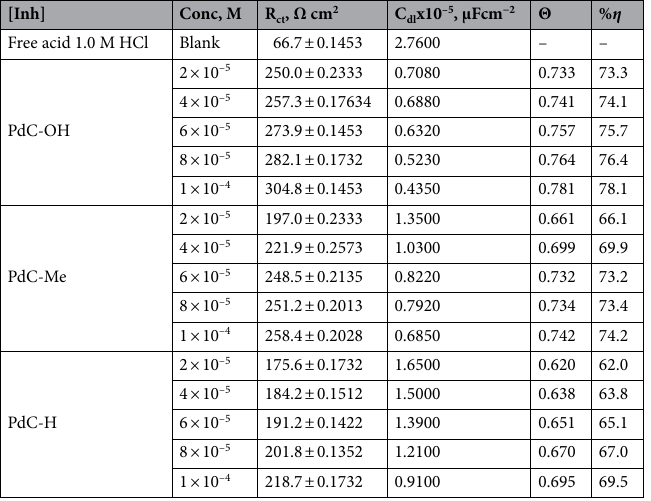
Table 8. Electrochemical kinetic parameters obtained from EIS technique for the corrosion of carbon steel in 1 M HCl at various concentrations of PdC-OH, PdC-Me and PdC-H at 25